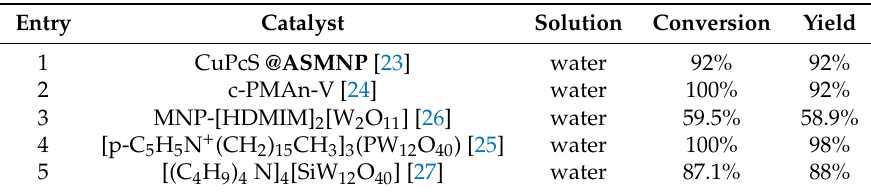
Table 1. The epoxidation of olefin by di ff erent